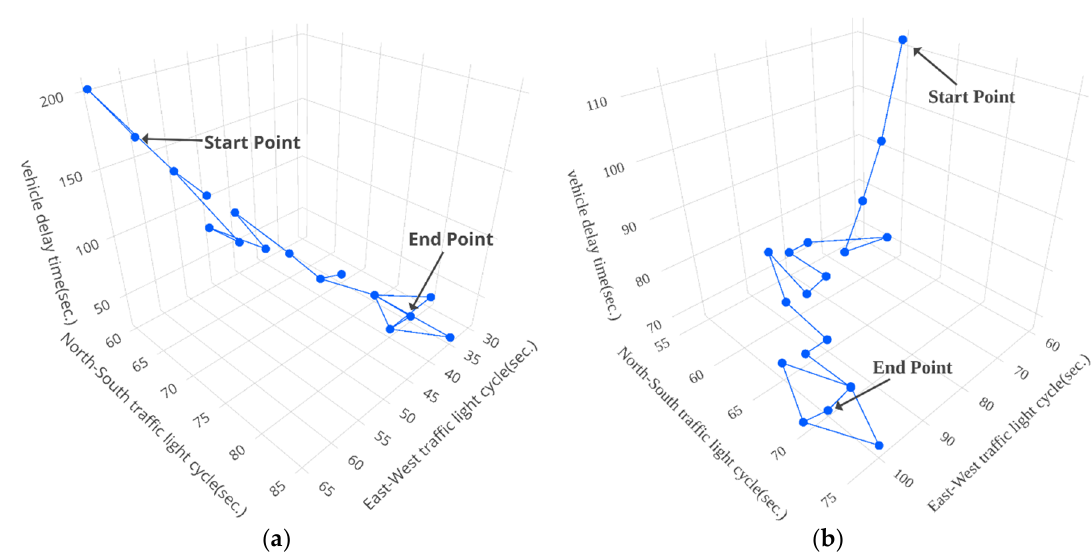
Figure 13. The results of vehicle delay by using our proposed modified Q-learning mechanism on Huanhe N. Rd. and Minsheng W. Rd. ( a ) from 8:00 a.m. to 9:00 a.m. ( b ) from 5:00 p.m. to 6:00 p.m.